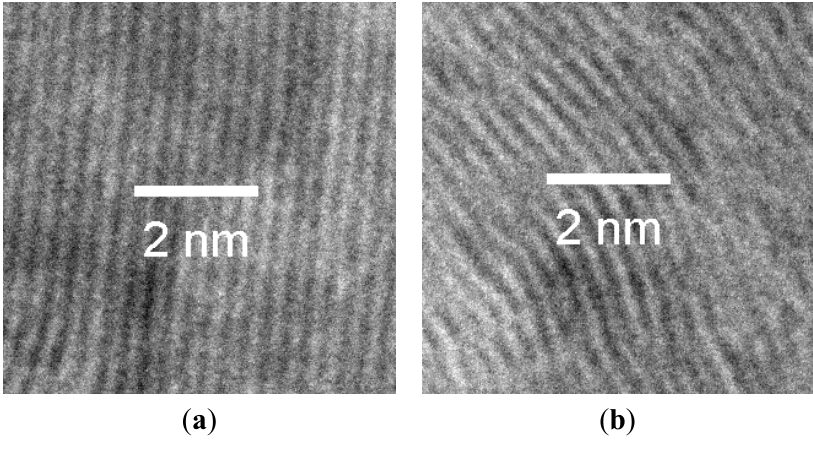
Figure 3. TEM images of ( a ) SMG and ( b ) MSC.